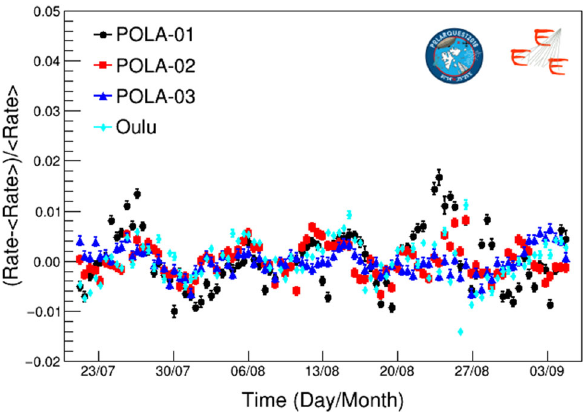
Fig. 29 Percentage rate fluctuations with respect to the average rate measuredbythethreePOLAdetectorsandbytheOuluneutronmonitor, the latter being located at the Sodankylä Geophysical Observatory of the University of Oulu, in Finland, as a function of